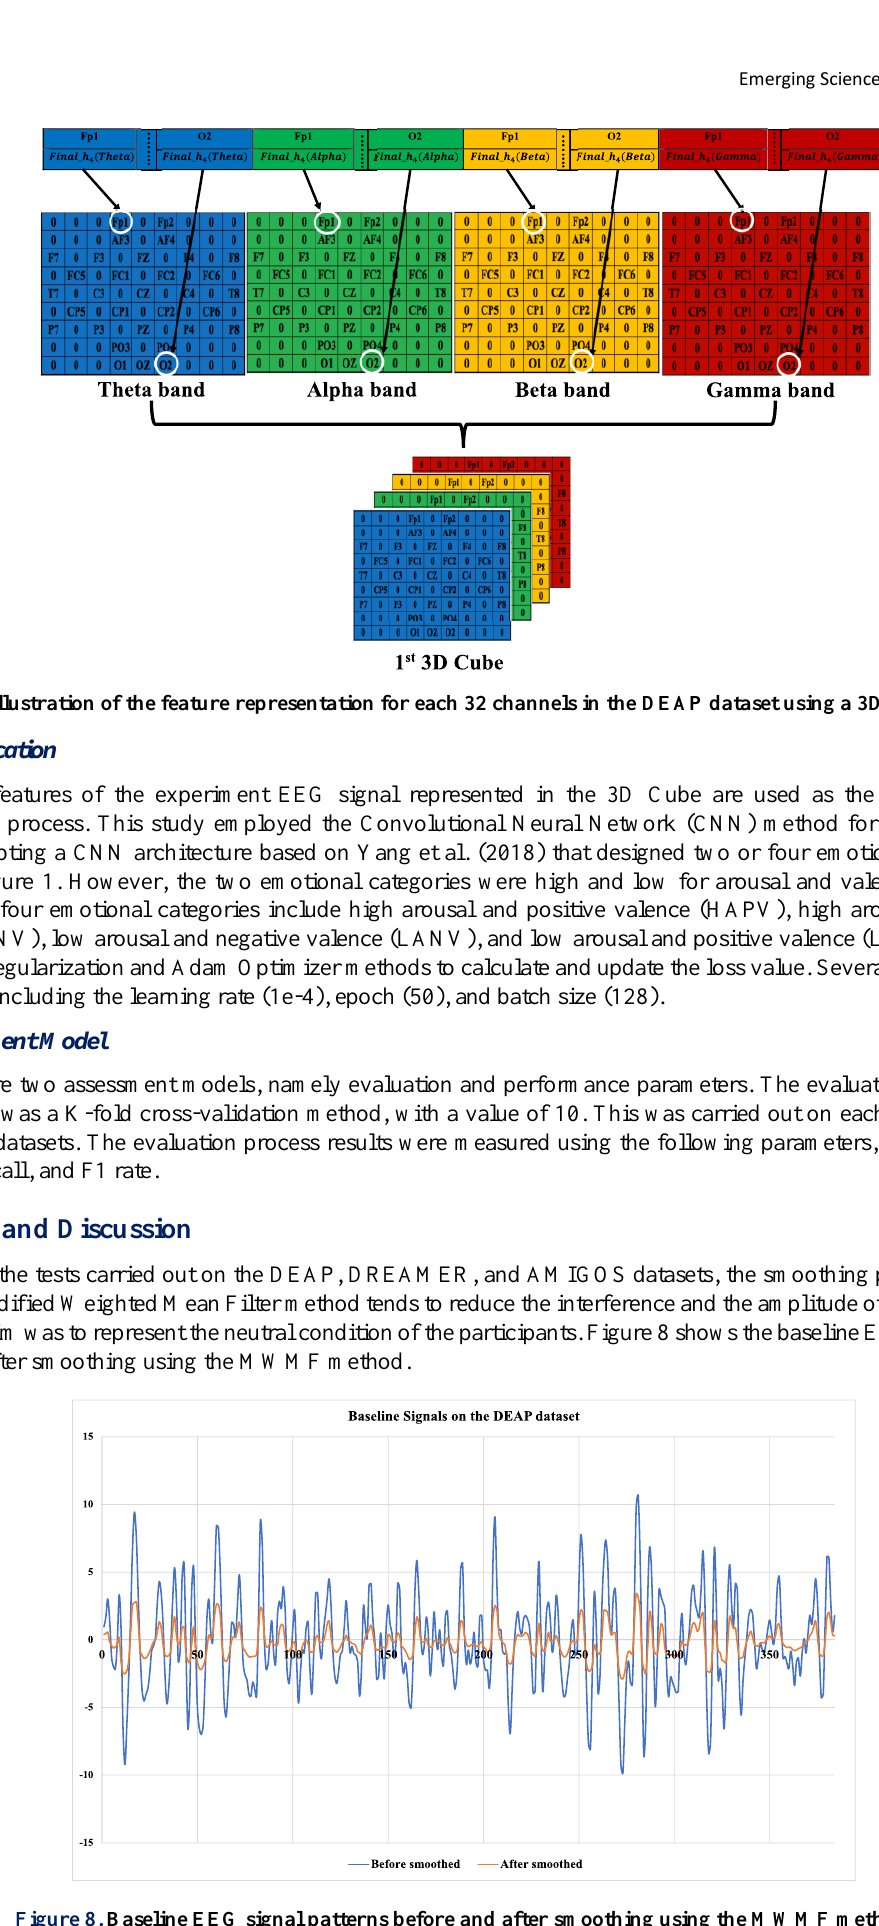
Figure 8. Baseline EEG signal patterns before and after smoothing using the MWMF